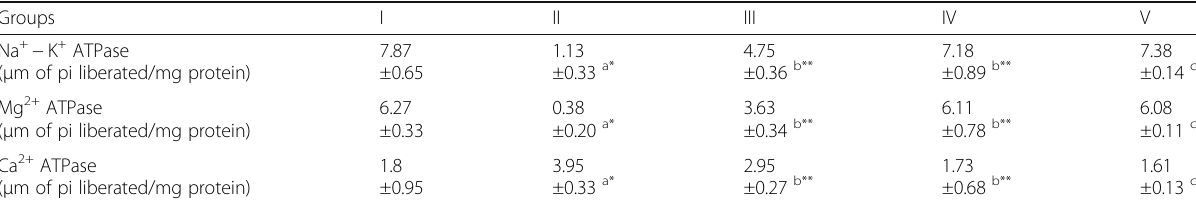
Table 7 Effect of aqueous extract of Caesalpinia bonducella L. on activities of membrane bound enzymes in heart of experimental animals Groups